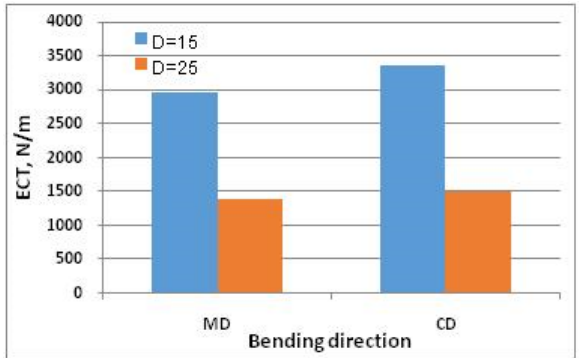
Figure 12. ECT of paperboard with thickness H = 30 and different mesh sizes, made of T200/F140/T200 papers.